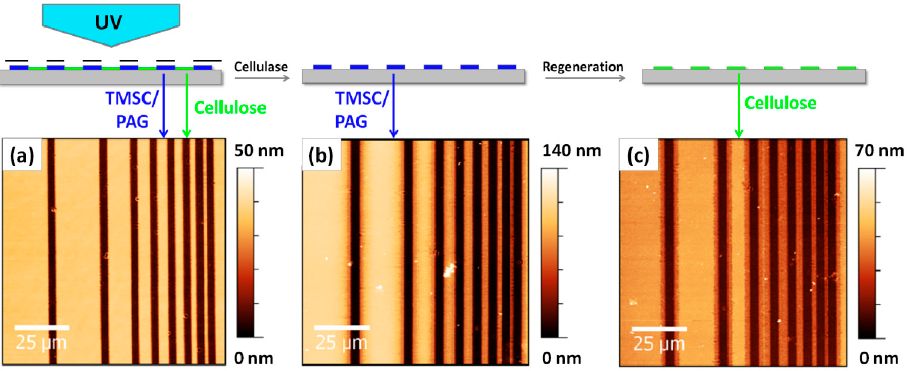
Figure 3. AFM images of TMSC thin films after illumination ( a ), enzymatic treatment ( b ) and regeneration ( c